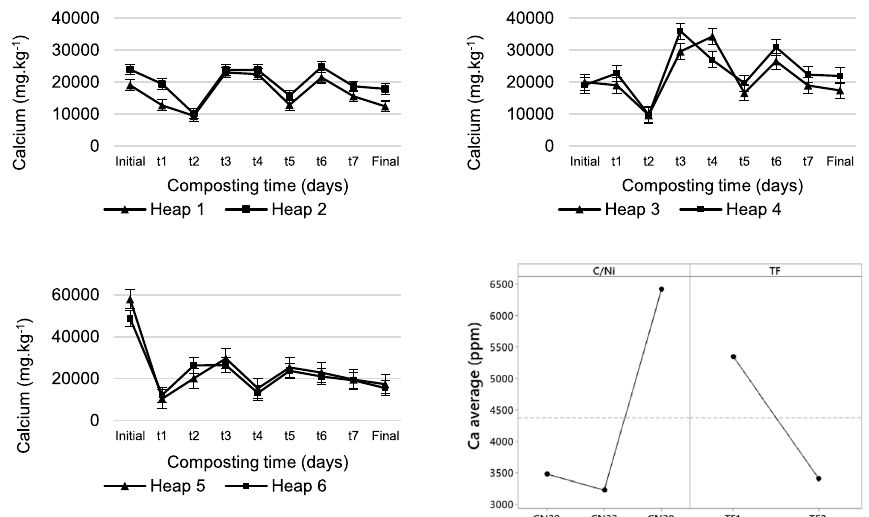
Fig. 3 Evolution of calcium content during composting for the six heaps and factors’ effect